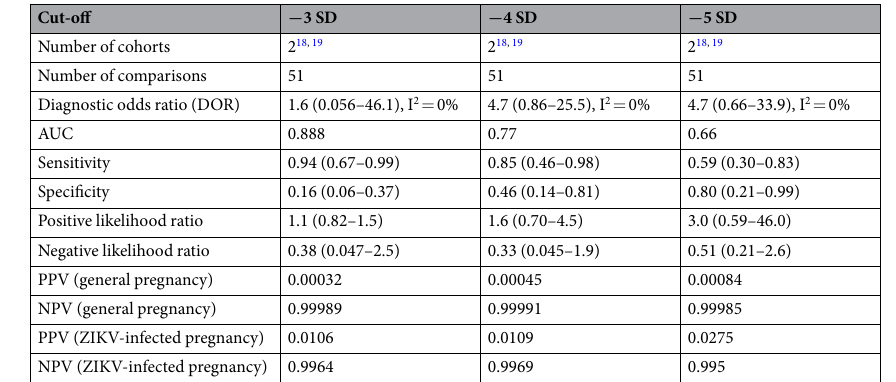
Table 2. Diagnostic accuracy of ultrasound measurements of BPD for prenatal assessment of microcephaly. Parentheses indicate 95% CI. Pre-test probabilities, i.e. incidence of microcephaly among general pregnancies and ZIKV-infected pregnancies were estimated as 0.0285% and 0.95%,